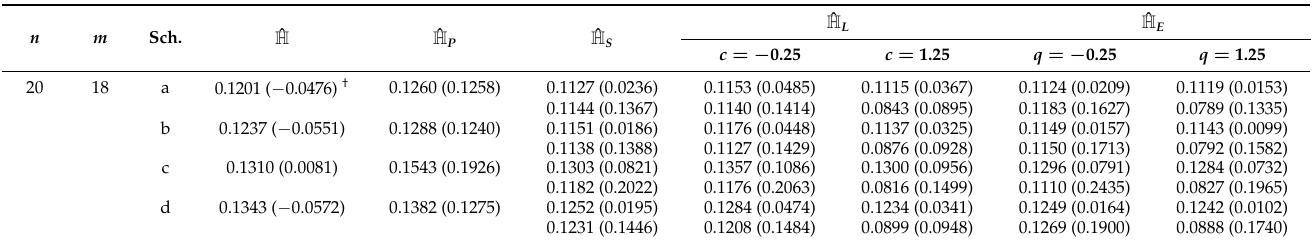
Table 3. The relative MSEs and biases of entropy estimators with classical and BayEst ( (cid:84) 1 = 1.5 and (cid:84) 2 =